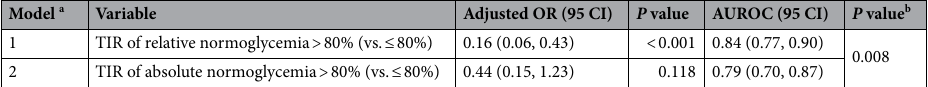
Table 3. Multivariate logistic regression analyses for hospital mortality. TIR time in range, OR odds ratio, AUROC area under the receiver operating characteristic curve. a Each model was adjusted according to age, sex, Acute Physiology and Chronic Health Evaluation II score and Charlson comorbidity index. b P value for the comparison of the AUROC of the two